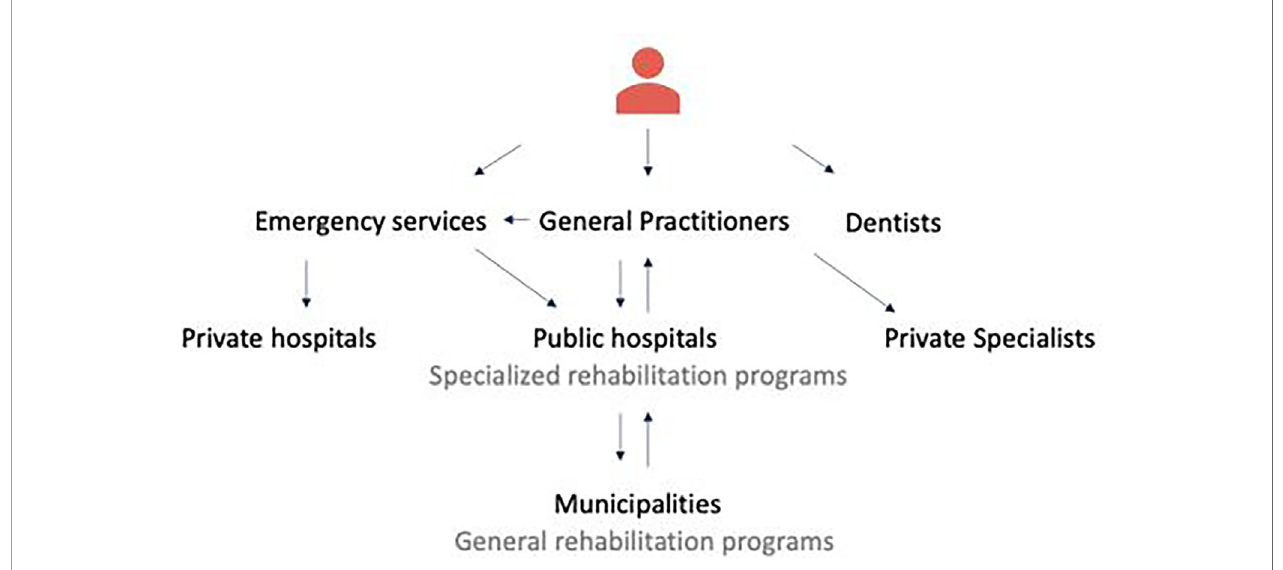
FIGURE 2 | A simpli fi ed version of a cancer patient ’ s journey in the Danish healthcare system. The care process starts with GP ’ s who are the gatekeepers of the secondary care, then moves to Hospitals for provision of medical treatment and specialized rehabilitation and fi nally to Municipalities for generalized rehabilitation services. Dentists are self-referred